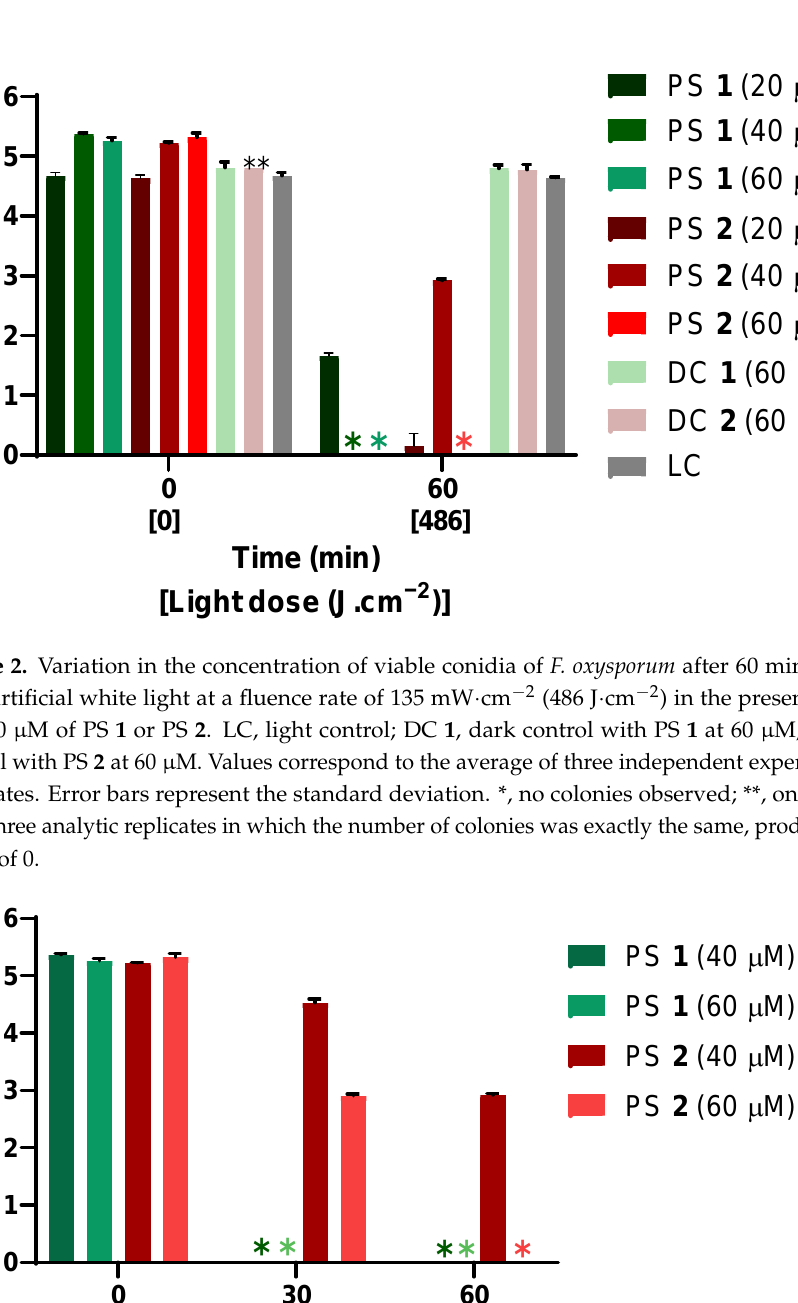
Figure 3. Variation in the concentration of viable conidia of F. oxysporum in the presence of 40 and 60 µM of PS 1 or PS 2 exposed to white light for 0, 30, and 60 min (135 mW·cm −2 ). Values are the mean of three replicate counts. Error bars represent the standard deviation. *, there was no colony